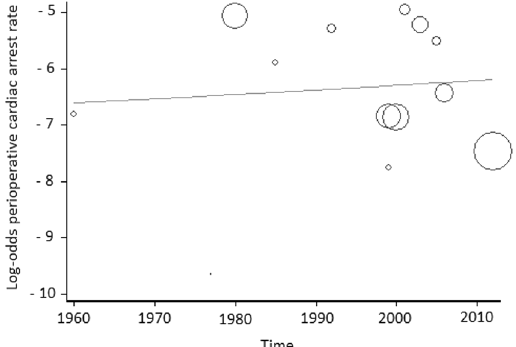
Figure 2. Meta-regression of perioperative cardiac arrest rates according to time. Each circle represents a study and indicates its weight in the analysis. The correlation between perioperative cardiac arrests and time was not significant (slope: 0.0079; 95% CI: − 0.0483 to 0.0642; P = 0.76).